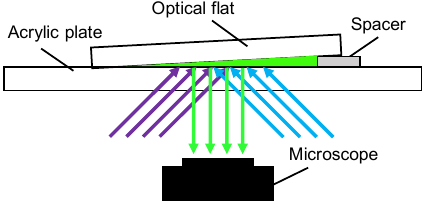
Figure 2. Experimental setup for calibrations of the relationship between fluorescence intensity and the coating film thickness.